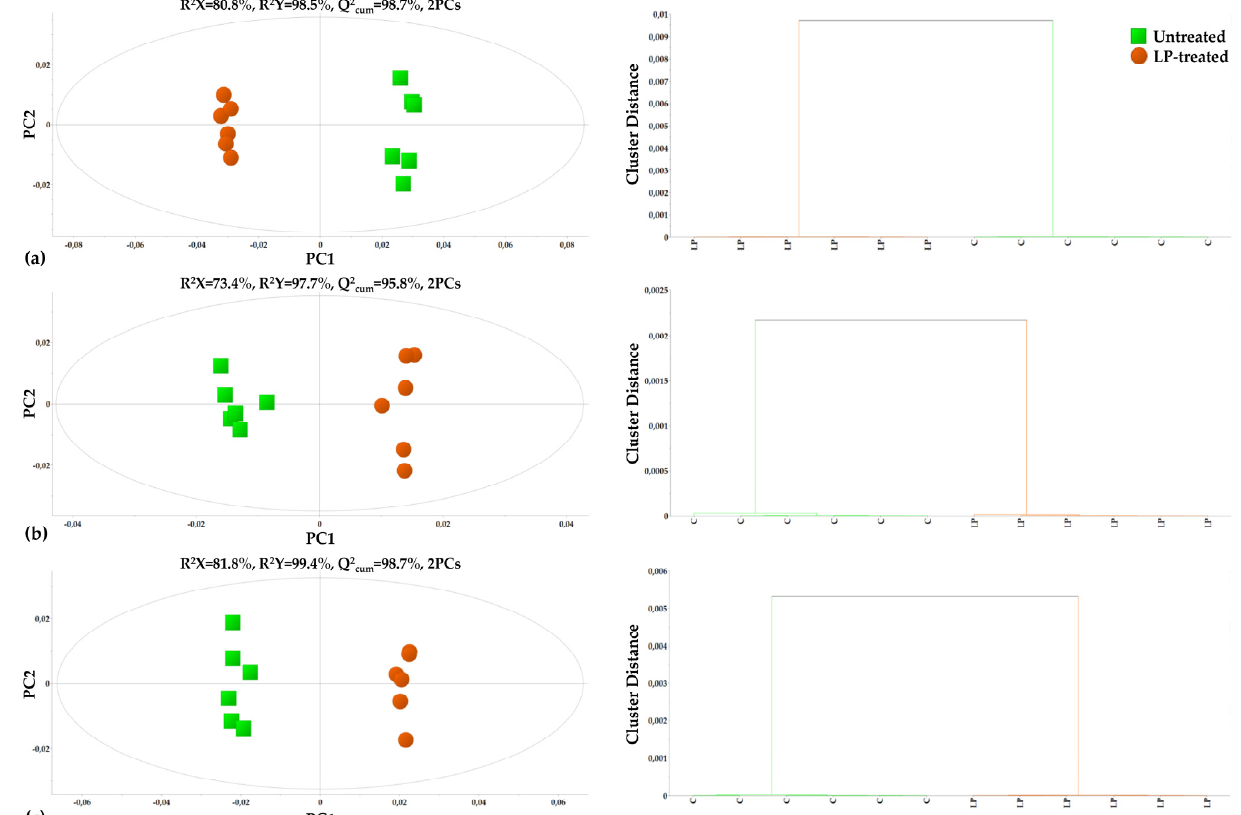
Figure 3. Visualization of the effect of olive tree endophytic Bacillus sp. lipopeptide (LP) extract on the recorded metabolite profiles of Colletotrichum acutatum performing partial least squares discriminant analysis (PLS-DA) (left) and hierarchical clustering using Ward’s method (right). Results of the analyses of the ( a ) GC/EI/MS, ( b ) 1 H NMR, and ( c ) the combined GC/EI/MS- 1 H NMR matrices are displayed. In the score plots, the ellipse represents Hotelling’s T 2 , the R 2 X and R 2 Y, the fraction of the sum of squares of X’s and Y’s that are explained by the components, and Q 2 (cum) , the cumulative fraction of the X’s total variation that can be predicted (PC; principal component).